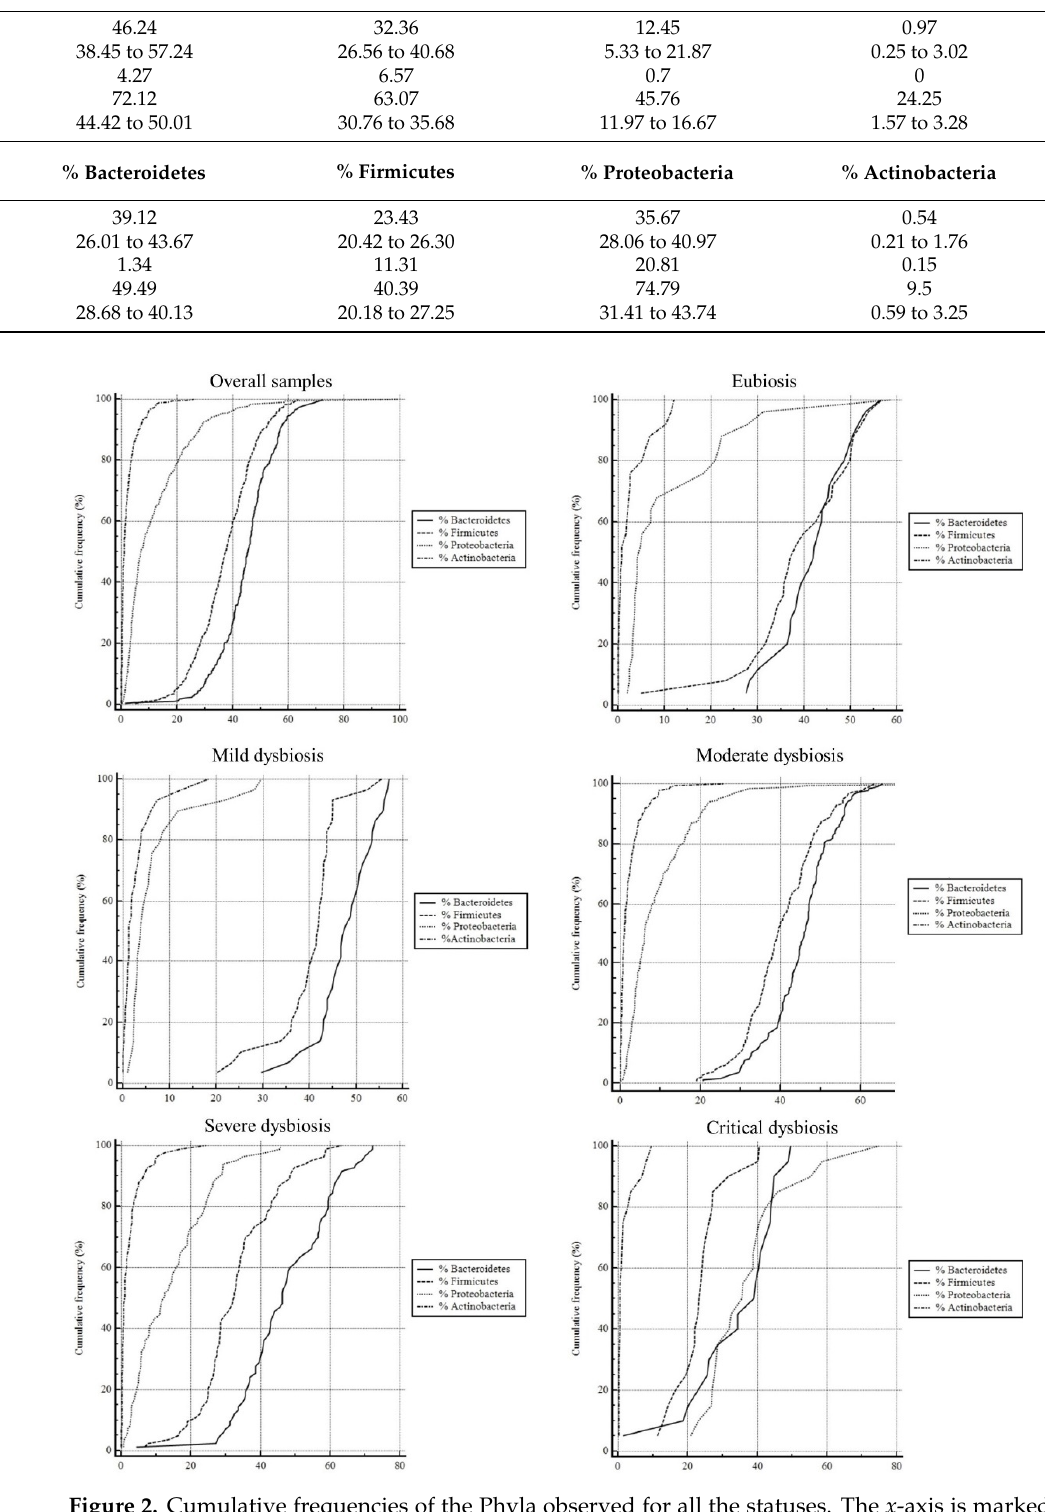
Figure 2. Cumulative frequencies of the Phyla observed for all the statuses. The x -axis is marked with the class intervals from the data set on a continuous scale. The y -axis represents the quartiles of the cumulative frequencies. Table 3. Median values, IQR, 95% CI, and minimum and maximum value of the percentages of the Phyla detected for all the statuses observed.